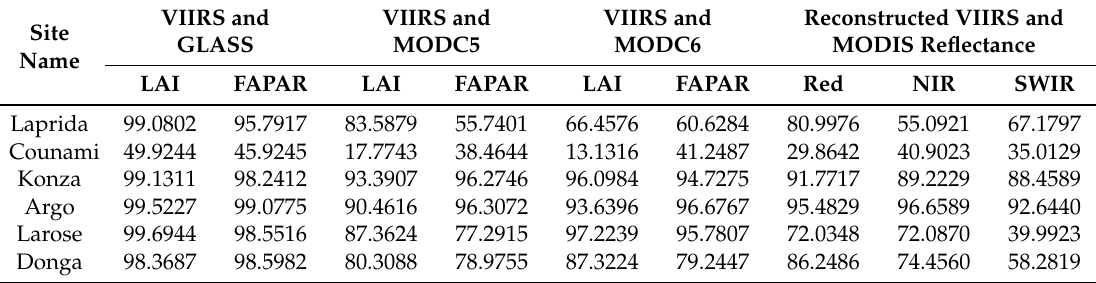
Table 3. Similarities (%) between the series of the VIIRS and GLASS, MODC5 and MODC6 LAI/FAPAR values and the series of the reconstructed VIIRS and MODIS surface